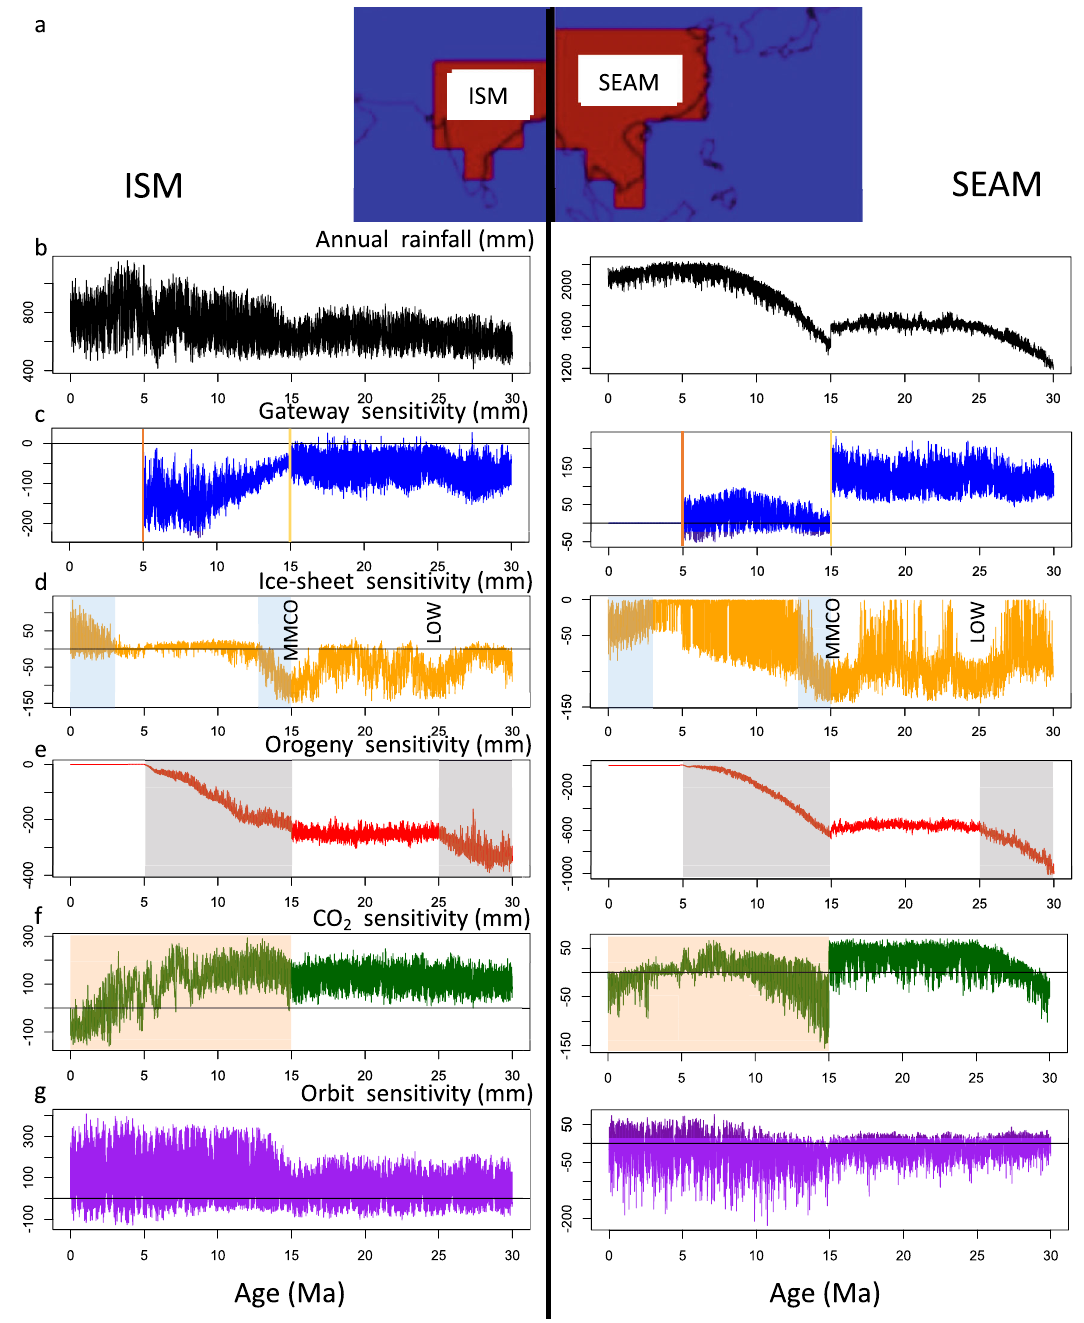
Fig. 3 Monsoon rainfall and sensitivities since 30 Ma, showing the difference between the baseline rainfall and rainfall assuming the input is fi xed at its preindustrial value. a Modelled areas for Indian Summer Monsoon (ISM, left panel) and South East Asian Monsoon (SEAM, right panel). b Emulated rainfall. c Gateway sensitivity. Vertical lines are closing of Tethys gateway (yellow) and closing of Panama gateway (orange) Vertical labels are the Mid- Miocene Climate Optimum (MMCO) and Late Oligocene Warming (LOW). d Sea-level/ice volume sensitivity. Light blue shading are times of glaciation. e Orography sensitivity. Grey shaded areas are periods of tectonic uplift. f CO 2 sensitivity. Light red shading shows period of CO 2 drawdown. g Orbital sensitivity. Note the different y-axis scales used for the different forcings and for the two monsoon